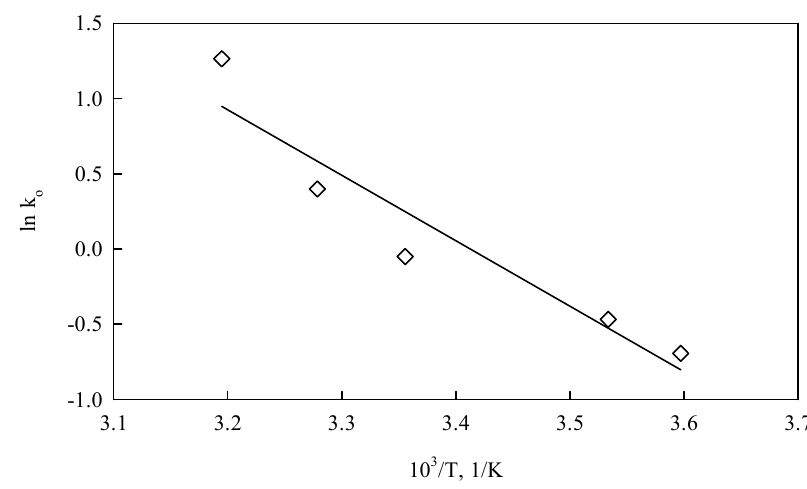
Figure 17. Arrhenius plot for the temperature range of 278 to 313 K.